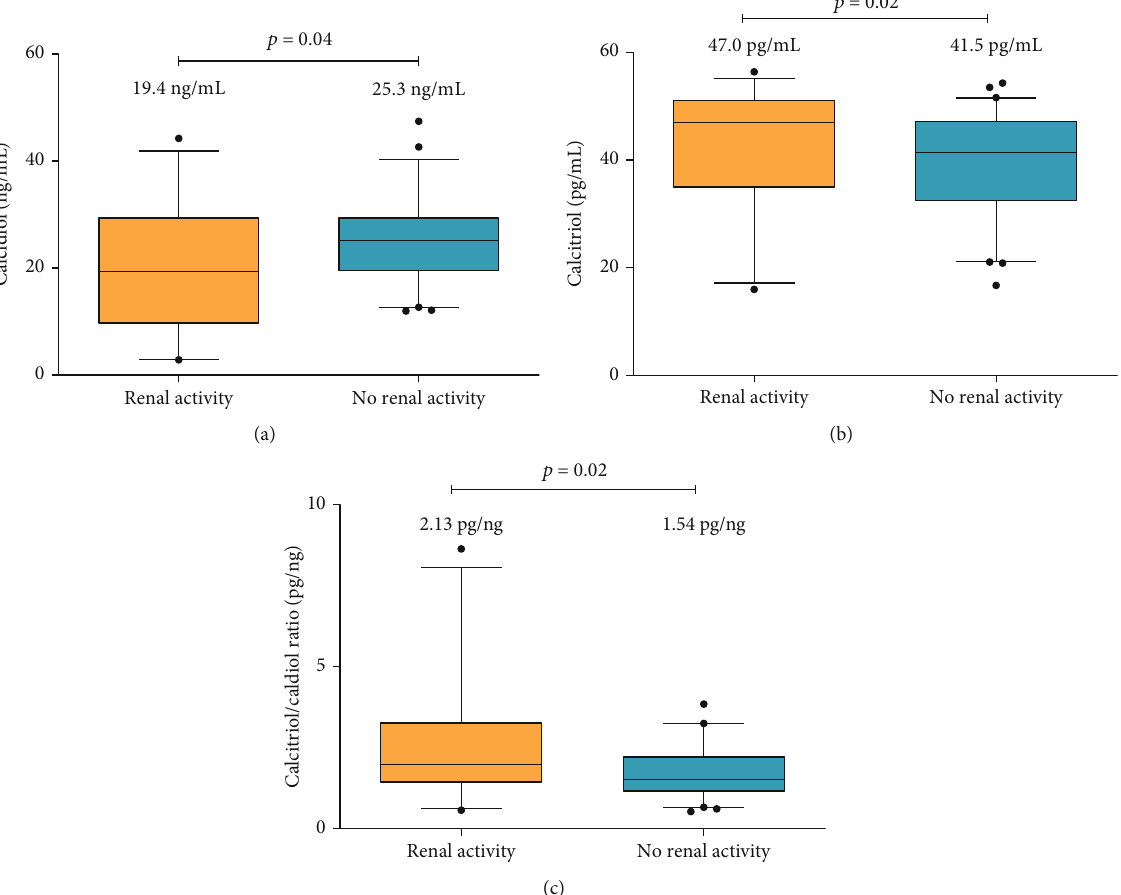
Figure 2: Vitamin D serum metabolites and vitamin D hydroxylation e ffi ciency ratio from SLE patients strati fi ed by renal disease activity. (a) Calcidiol serum levels (ng/mL) from SLE patients with renal activity (3.26 – 36.6ng/mL) and no renal activity (12.7 – 40.4ng/mL); (b) calcitriol serum levels (pg/mL) from SLE patients with renal activity (19.0 – 53.2 pg/mL) and no renal activity (21.8 – 51.2pg/mL); (c) calcitriol/calcidiol ratio (pg/ng) from SLE patients with renal activity (0.76 – 15.3 pg/ng) and no renal activity (0.71 – 3.21pg/ng). Data provided in median ( p 5 th – p 95 th in parenthesis), Mann – Whitney test. SLE: systemic lupus